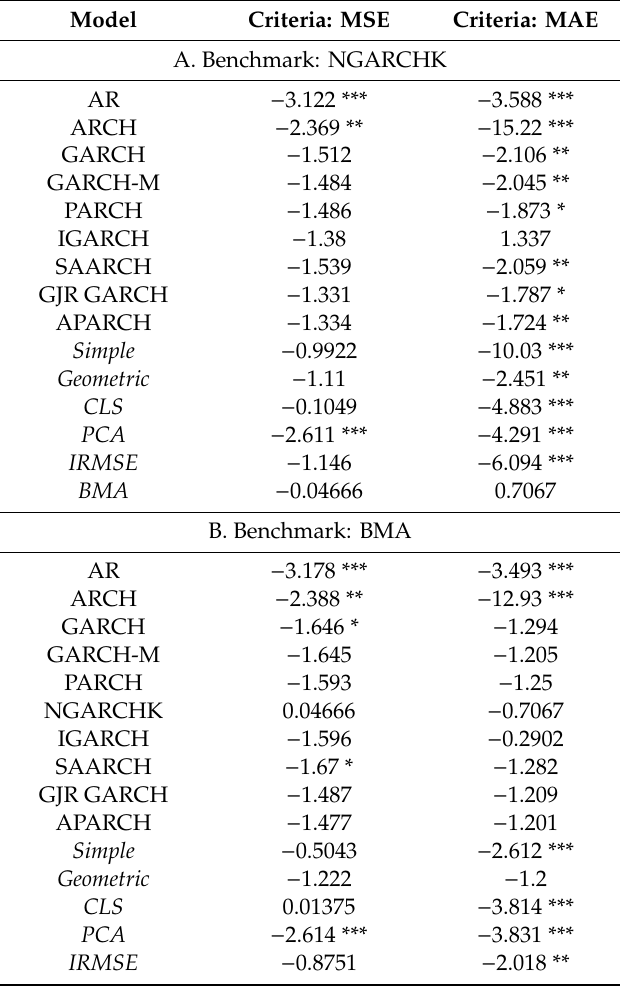
Table A5. SREC prices: Diebold–Mariano test statistic for forecast accuracy of NGARCHK and BMA. MSE and MAE are used as criteria (following Mohammadi and Su, [79]). In panel A, we evaluate the forecast accuracy of the NGARCHK compared to that of all other models; while in panel B, we evaluate the BMA combination with all other